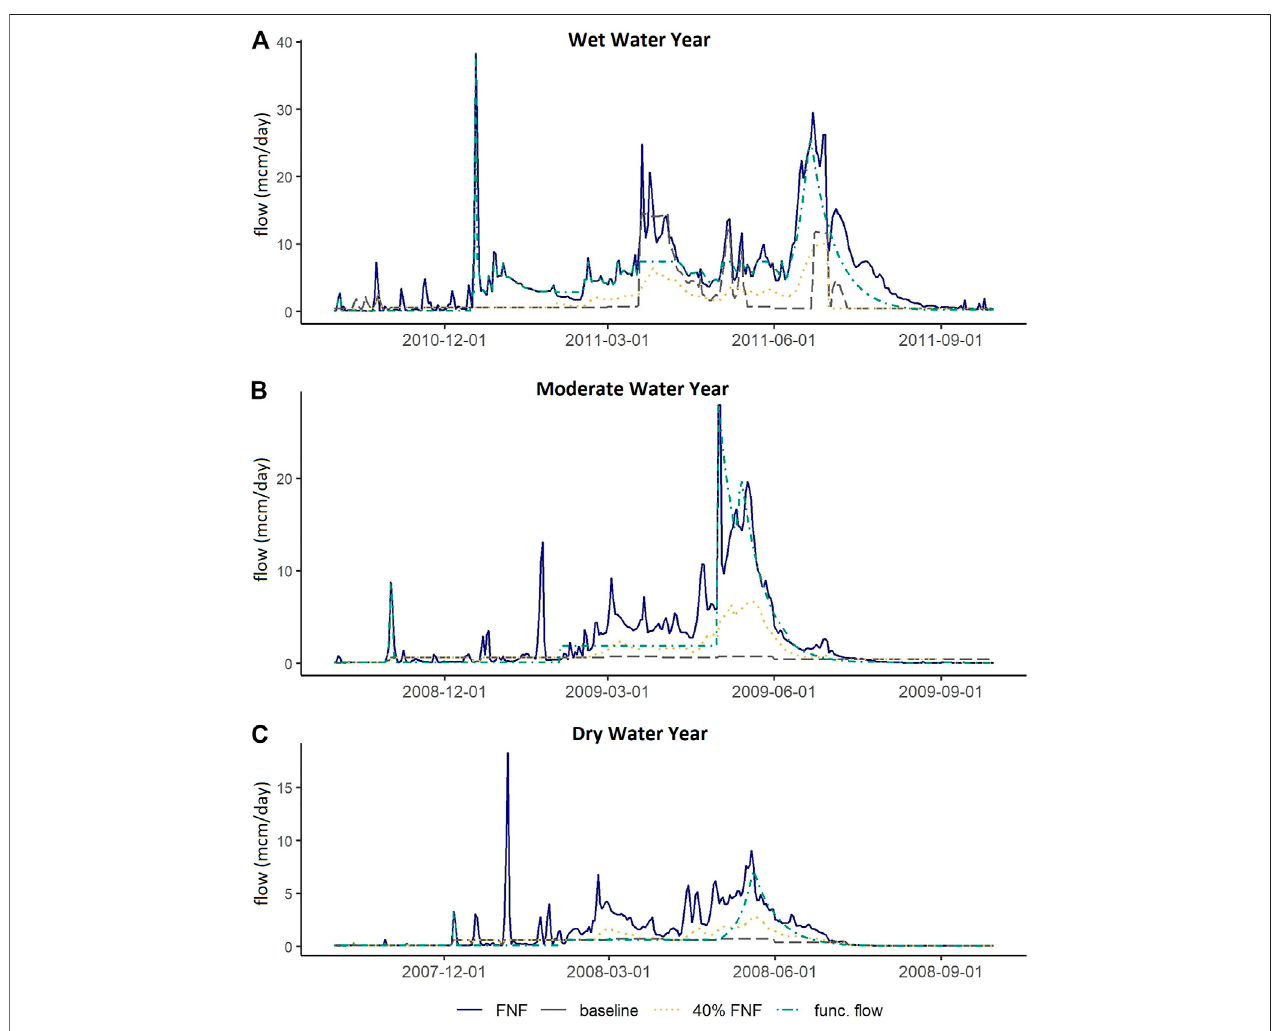
FIGURE 3 | Full natural fl ows are compared to the base fl ow, 40% FNF, and functional fl ow strategies for example (A) wet, (B) moderate, and (C) dry water years.